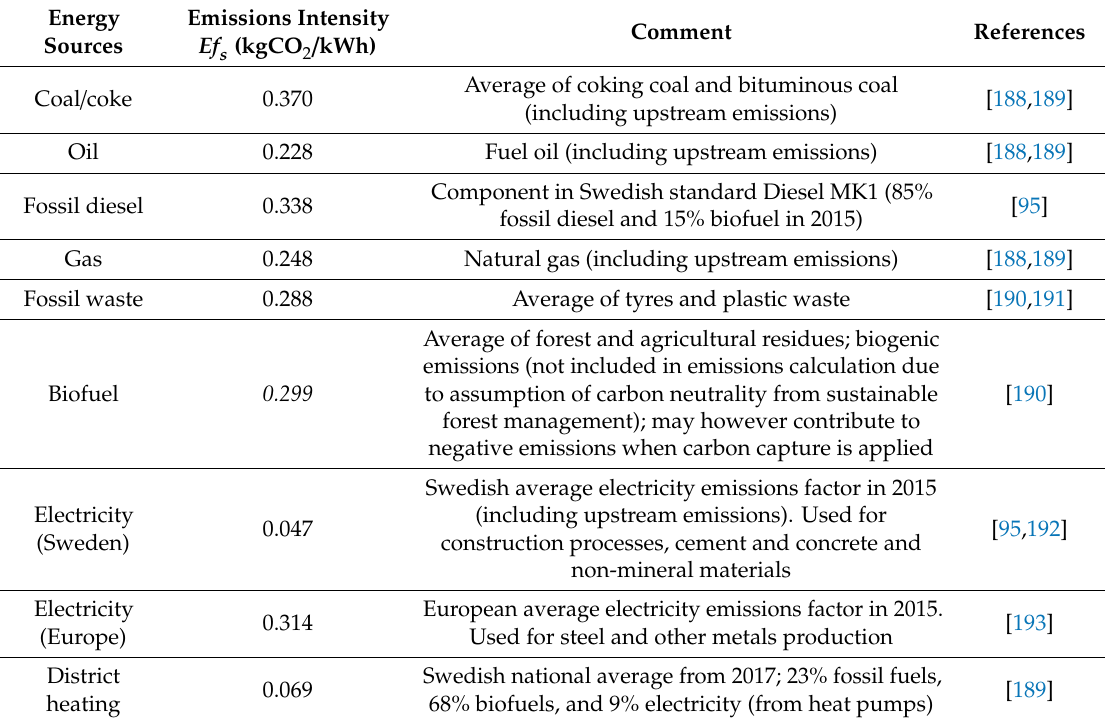
Table A2. Emissions intensity factors for energy sources.